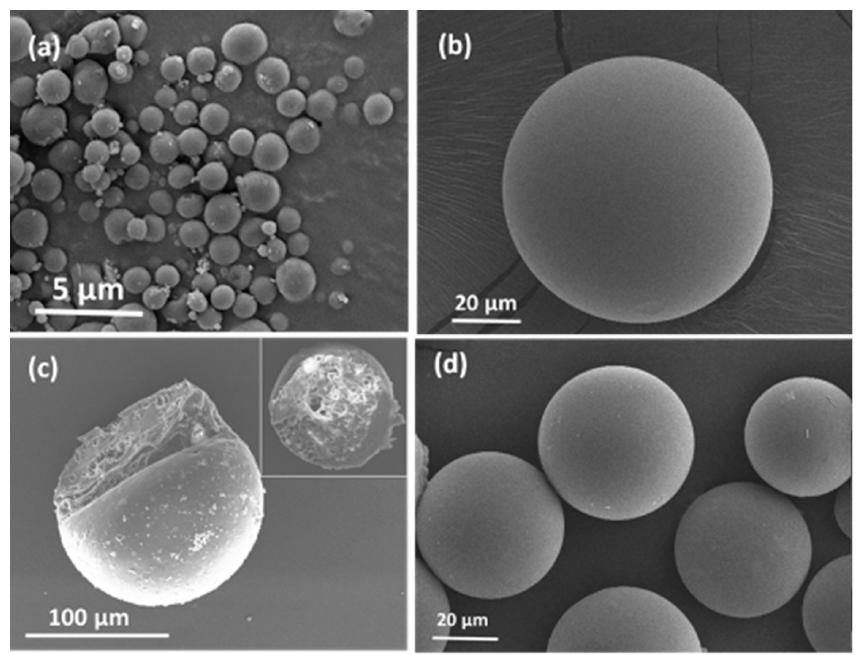
Figure 3. Scanning electron microscopy (SEM) images of ( a ) dextran-rhGH micro particles, ( b ) exterior image of a PLGA microsphere, ( c ) interior image of PLGA microsphere, and ( d ) rhGH loaded PLGA microspheres.